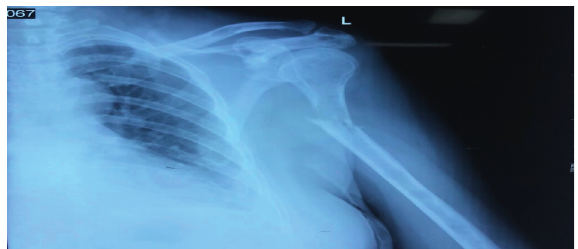
Figure 1: Humerus fracture with lytic lesion.